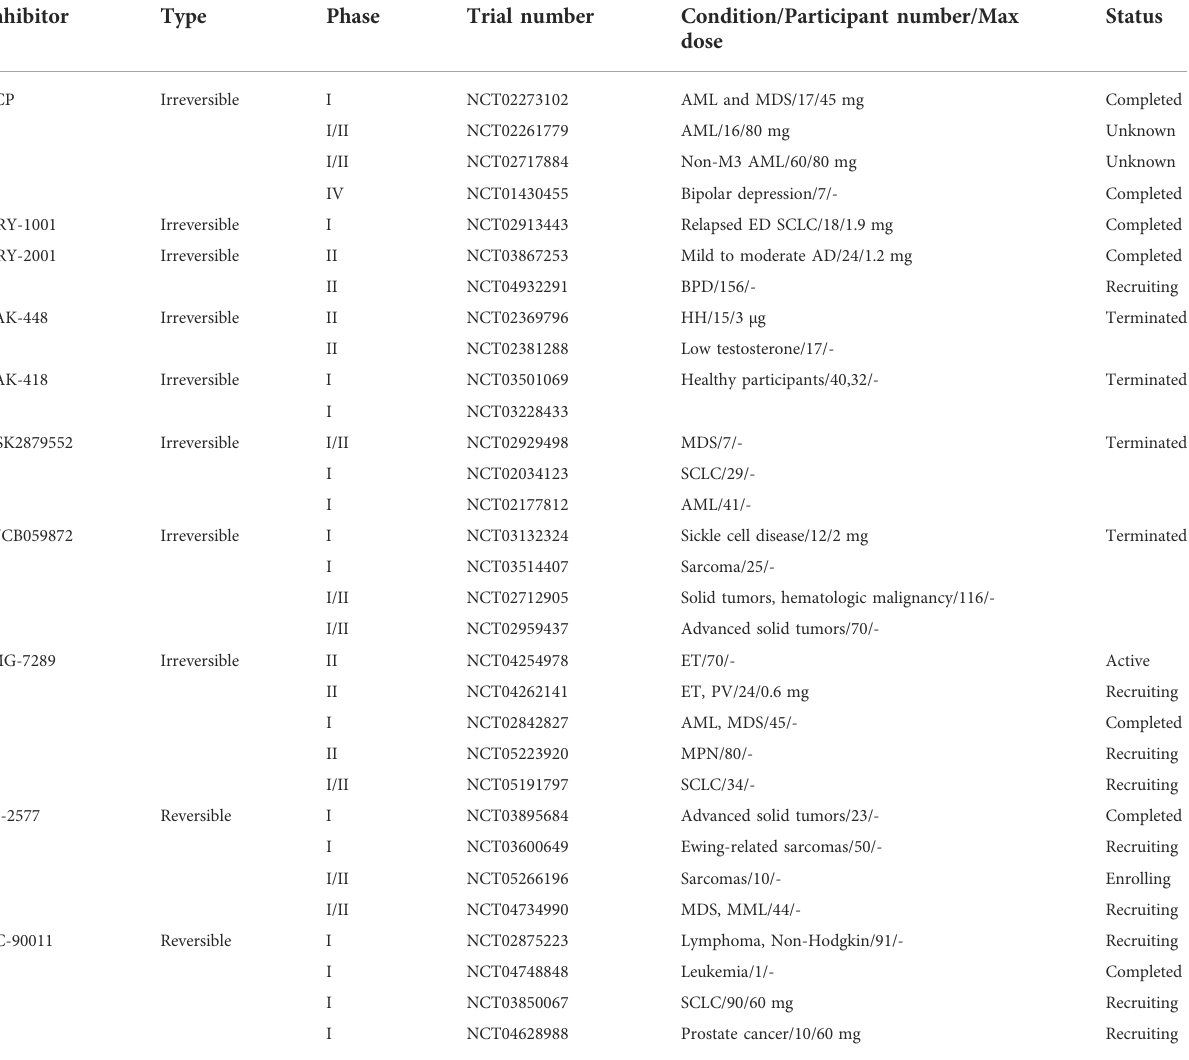
TABLE 1 LSD1 inhibitors in clinical trials (ClinicalTrails.gov in May